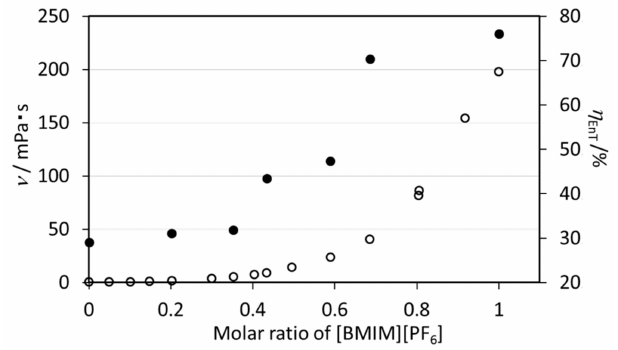
Figure 5. η EnT (filled circles) and ν (open circles) as functions of the [BMIM][PF 6 ] mole